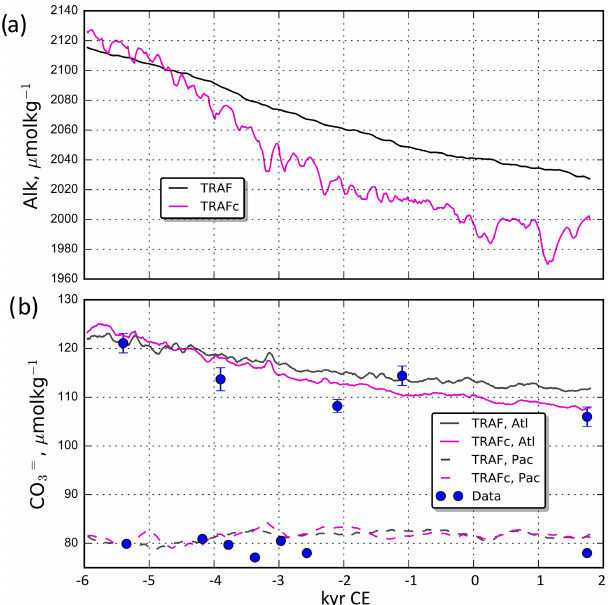
Figure 7. (a) 100-year moving average of global surface alkalin- ity, µmolkg − 1 . (b) 100-year moving average of carbonate ion con- centration (µmolkg − 1 ), averaged for nine neighbouring model grid cells centred in the deep Atlantic (12 ◦ N, 60 ◦ W; 3400m) and deep Pacific (1 ◦ S, 160 ◦ W; 3100m). The data (circles) are [CO = sites VM28-122 and GGC48 reconstructed by Yu et al. (2013), which appropriately correspond to the ocean grid cells accounting for the model bathymetry mask. Data uncertainties (1 σ ) reported for the Atlantic by Yu et al. (2013) are indicated by whiskers. 35‰ salinity is used for model unit conversion from m − 3 to kg − 1